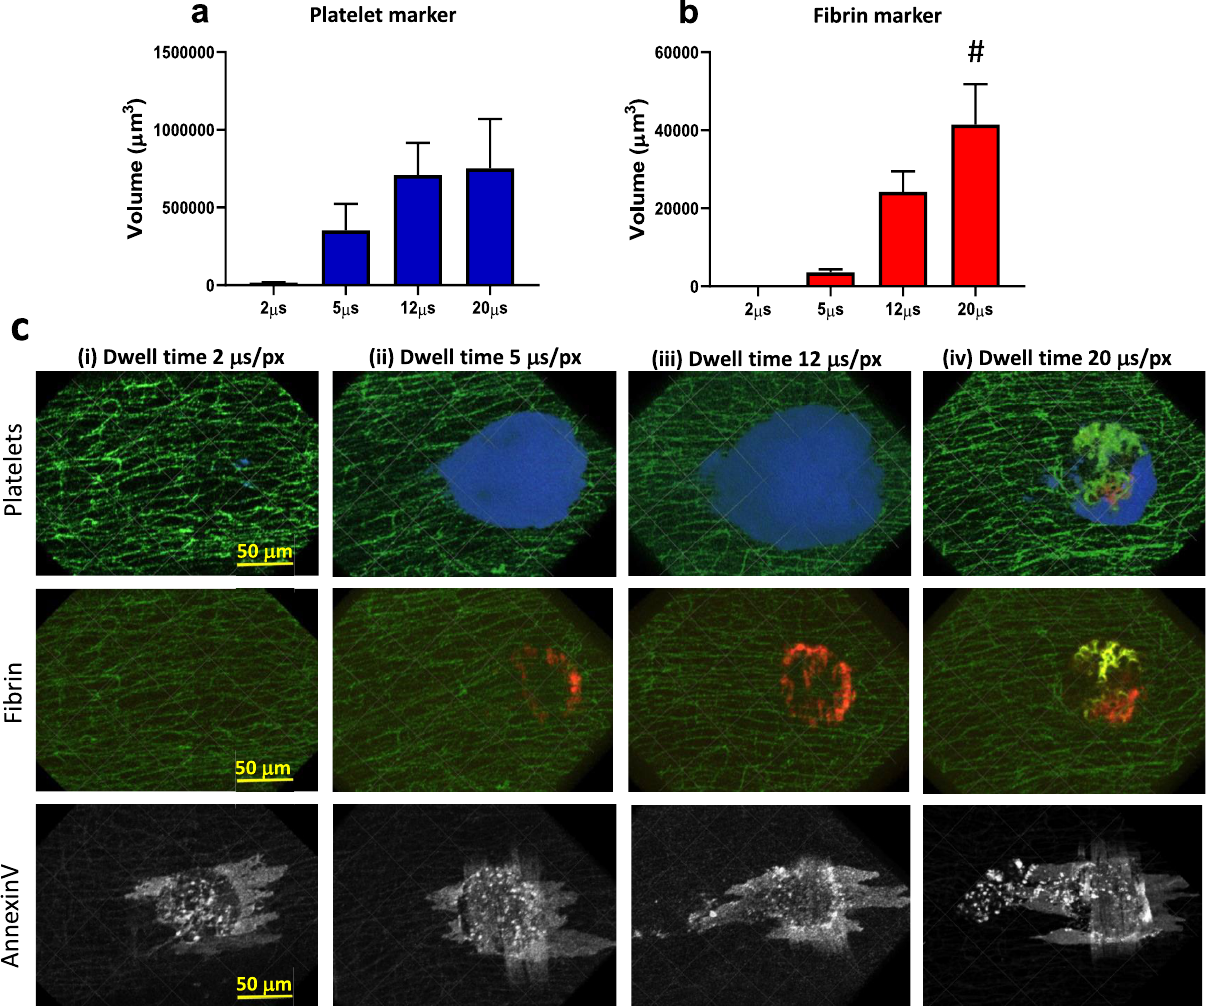
Figure 3. Optimisation of scanning-LIEI pixel dwell time (laser dose). The speed of the ablation scanner was varied to obtain different laser exposure times. ( a ) Quantification of platelet volume 5 min after injury at different scan speeds (2, 5, 12 or 20 μs/pixel). ( b ) Quantification of fibrin volume 5 min after injury at different scan speeds (2, 5, 12 or 20 μs/pixel) (n = 3–11 injuries from 3 to 5 mice). ( c ) Representative XY surface 3D reconstructions of thrombi (platelets blue, fibrin red), annexin V (white), and autofluorescent elastin layer (green). Blood flow is from right to left. Top row: platelet accumulation 5 min after injury. Middle row: Fibrin formation 5 min after injury. Bottom row: Annexin V binding > 30 min after injury. The speed of the ablation scanner was (1) 2 μs/pixel, (2) 5 μs/pixel, (3) 12 μs/pixel or (4) 20 μs/pixel. Note the autofluorescence of damaged tissue in the 488 nm (green) and 546 nm (red) channels (seen as yellow in the fibrin image) after 20 μs/pixel scan speed (see also Supplementary Fig. 1C) causing an artificially high signal in the fibrin (546 nm) channel (#). Also note the annexin V-positive endothelium in the 2 μs/px scan speed but lack of fibrin formation or platelet accumulation after 5 min indicating that endothelial damage/activation alone is not sufficient for stable thrombus formation in this model. Scale bar and grid size 50